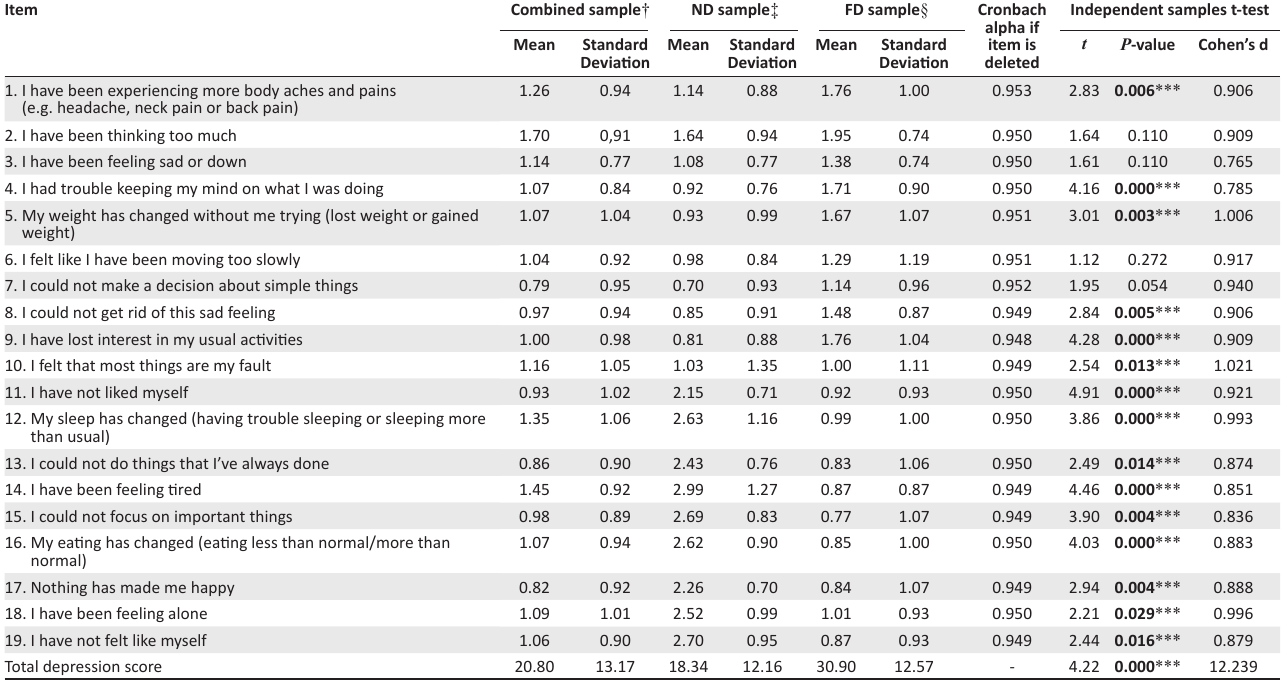
TABLE 3: Descriptive statistics and independent samples t-test. Item